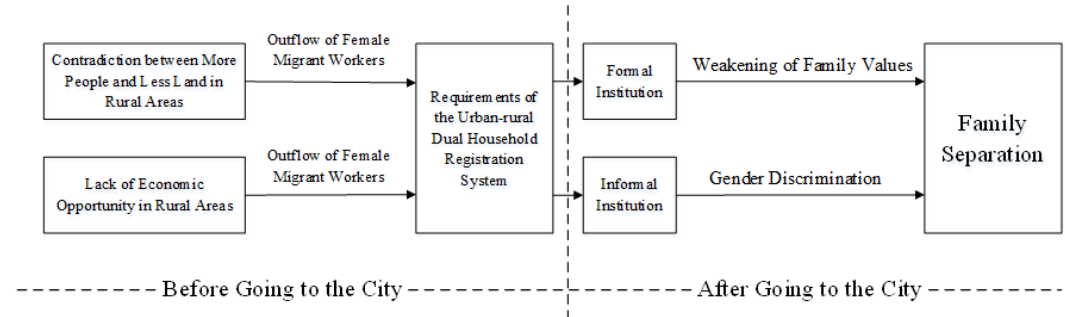
Figure 3. Research framework of this article (made by authors).